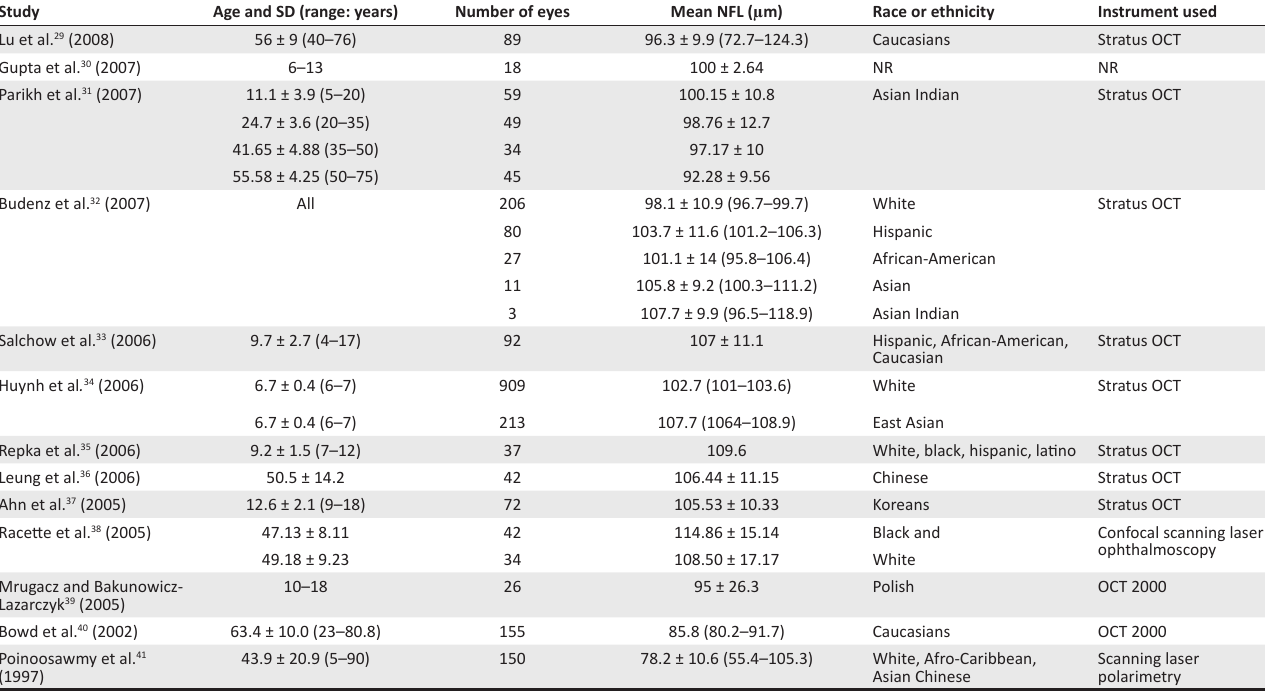
TABLE 1 (Continues...): Study characteristics and mean thickness of the retinal nerve fibre layer in different ethnic populations. All studies included both males and females. Study Age and SD (range: